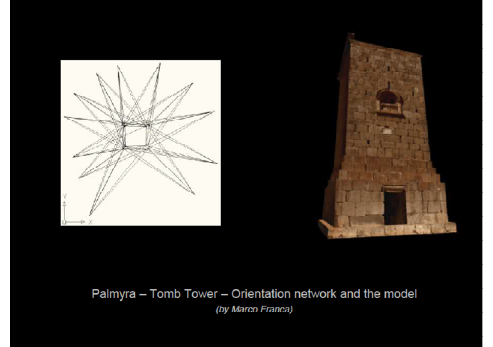
Figure 20. The Tower Tomb of Elahbel modeled by an Italian team led by G. Fangi. Courtesy G. Fangi and M.